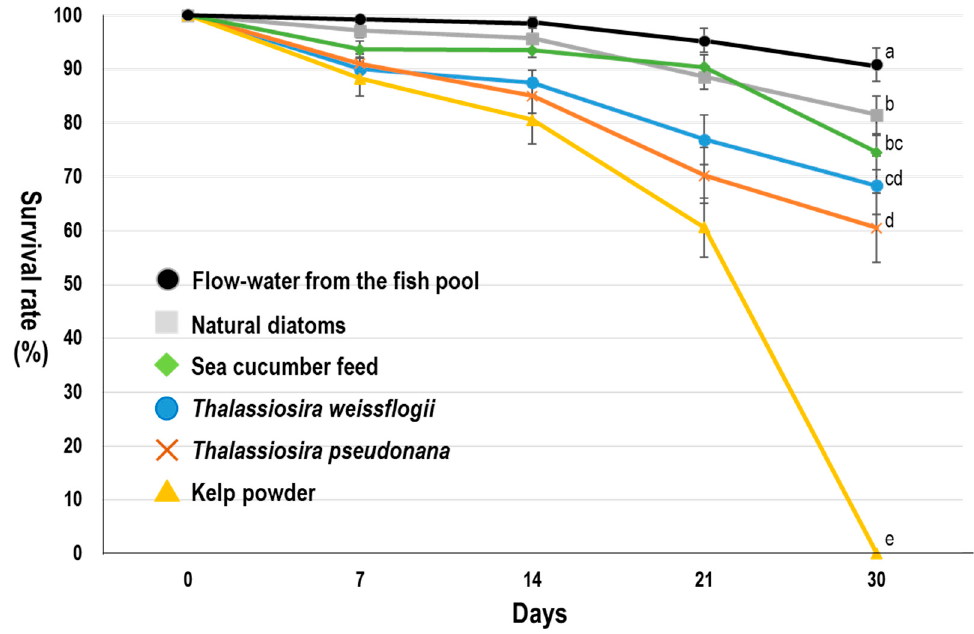
Figure 3. Survival rates of newly metamorphosed juvenile Laevistrombus canarium fed with different diets. The data of flow water from the fish pool were from outdoor tanks. We use 240 L tanks (90 × 60 × 45 cm) for juveniles and use flow-water from the 2000 tons fish pool (Figure 2A). Groups show significant differences by the 30th day (ANOVA; p < 0.001). Lowercase letters indicate significant differences (Tukey’s HSD; p < 0.05) of examined variables between diets. Bars present the mean ± standard deviation.